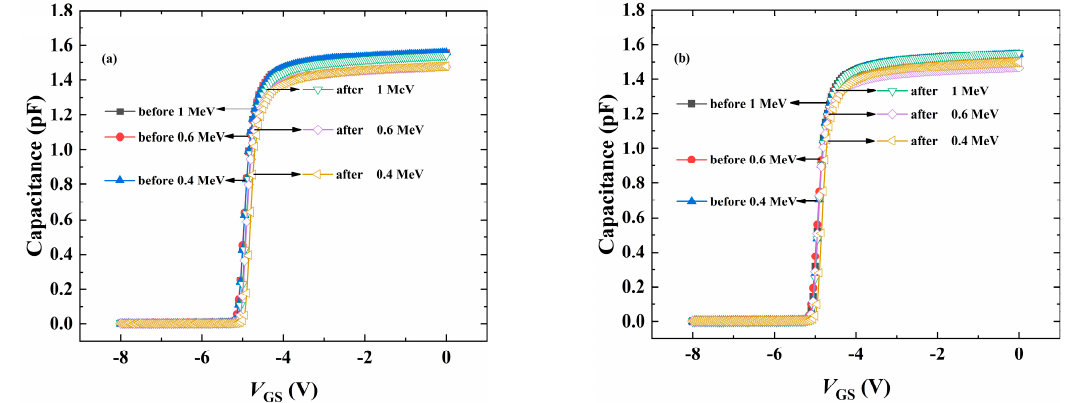
Figure 2. Measured C – V curves before and after proton irradiation for Device 1 ( a ) and Device 2 ( b ).